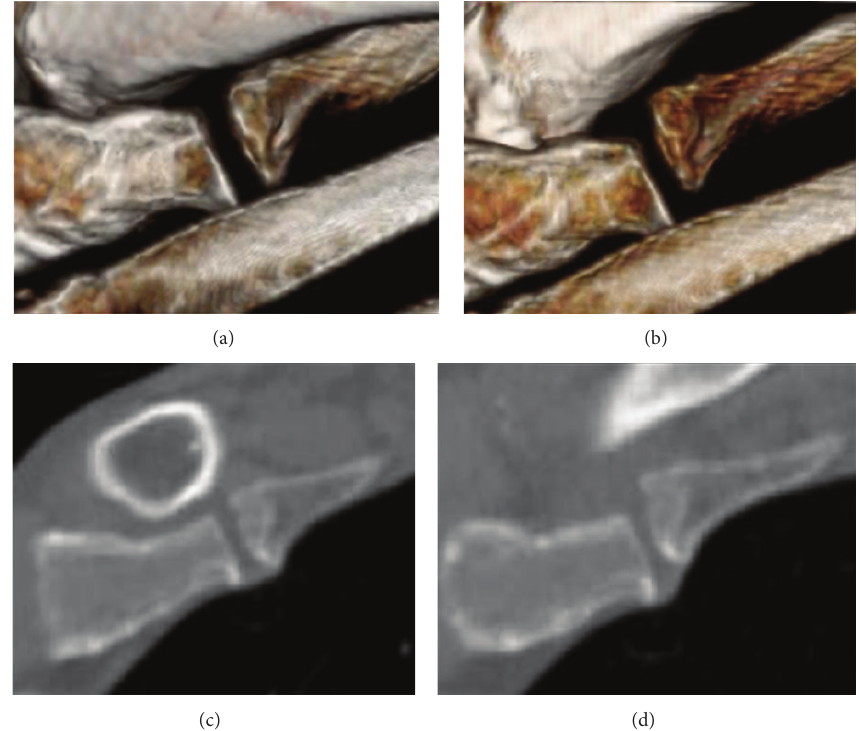
Figure 3: Computed tomography (CT) images of the left first sternocostal synchondrosis. Three-dimensional reconstruction (a, b) and coronal CT images (c, d) showing subluxation of the left first rib in two different positions, with the arm hanging naturally (a, c) and elevated (b,